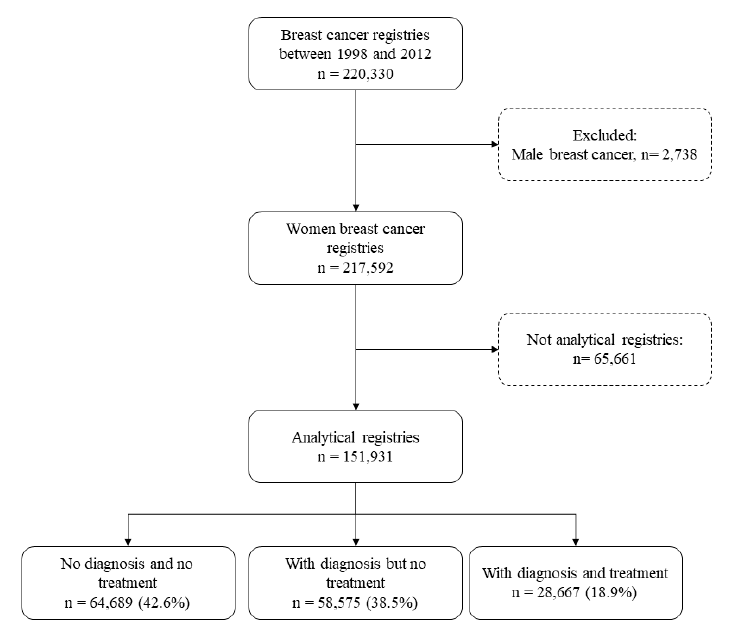
Figure 1. Data sorting procedure.